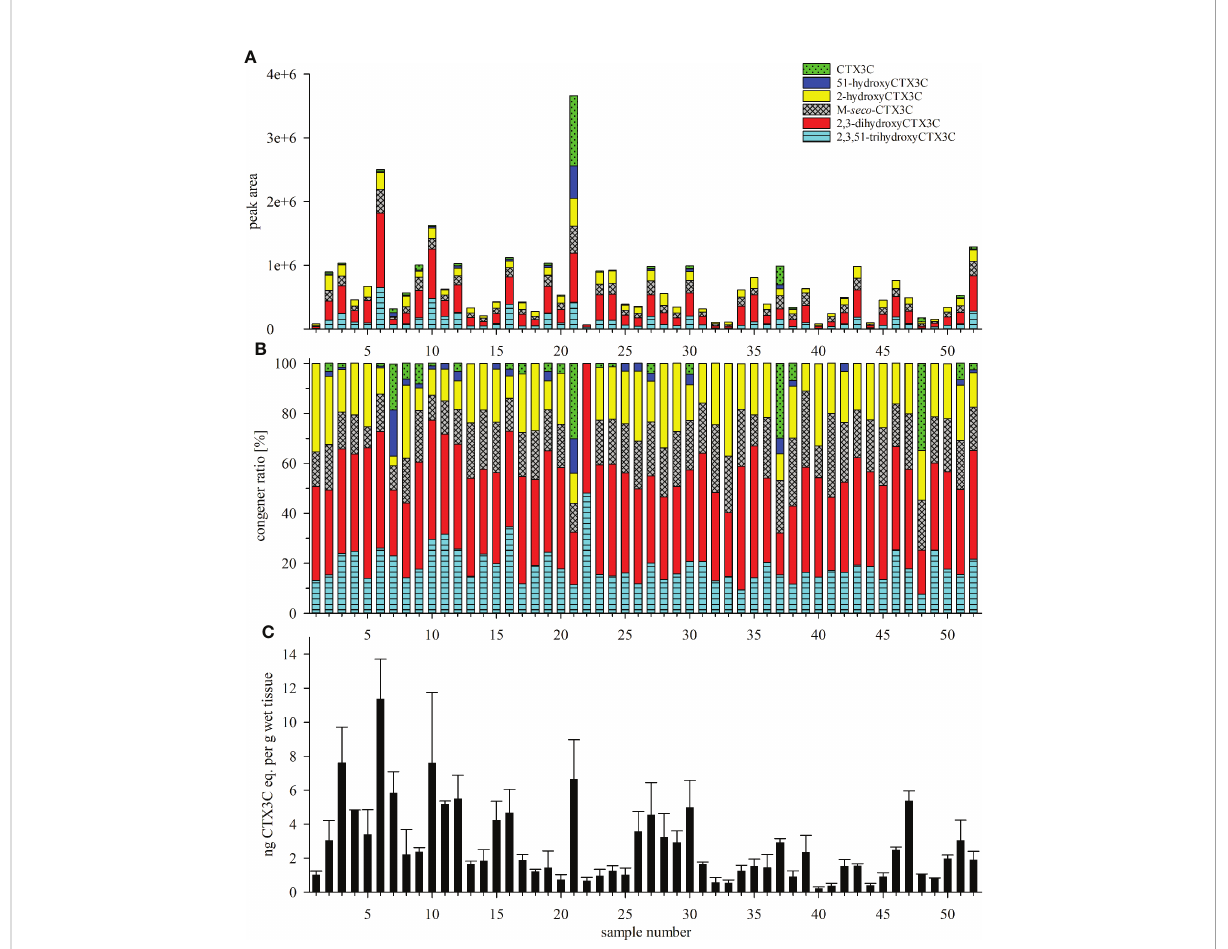
FIGURE 4 (A, B) Toxin pro fi le and (C) composite toxicity determined for the fi fty-two L. bohar tissue samples from the Paci fi c Ocean (samples 1 to 45) and the Indian Ocean (samples 46 to 52); (A) absolute and (B) relative peak areas of the respective congeners determined by LC-MS/MS analysis, areas of the 49-epimer and the 49R-congener were combined; (C) toxicity equivalents expressed as ng CTX3C eq. per g wet tissue were determined by N2a-bioassay; error bars represent the standard deviation from three independent analyses performed for each samples (i.e., minimum three independent assays, each assay includes three replicate points); N2a-bioassay data according to Loef fl er et al. (2022) and Loef fl er et al. (2022,